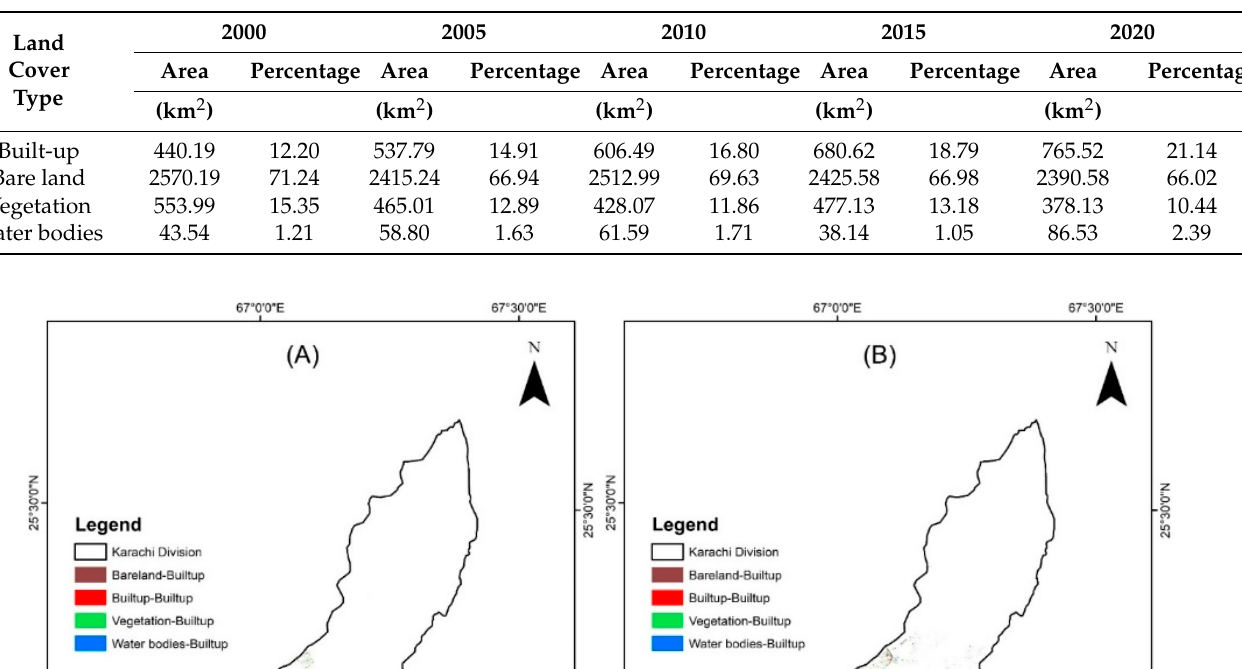
Table 4. LULC changes in Karachi during the period 2000–2020.